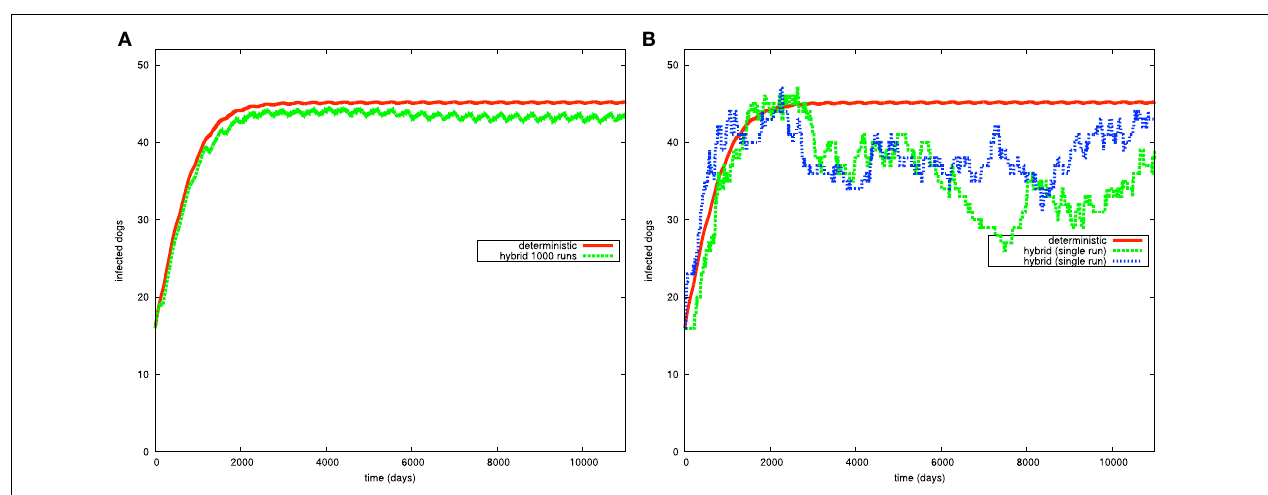
FIGURE 8 | Simulation results of the Chagas model in Figure 4 for the dog population: (A) continuous and average hybrid time course result (1000 runs), (B) deterministic and two single runs of hybrid simulation.